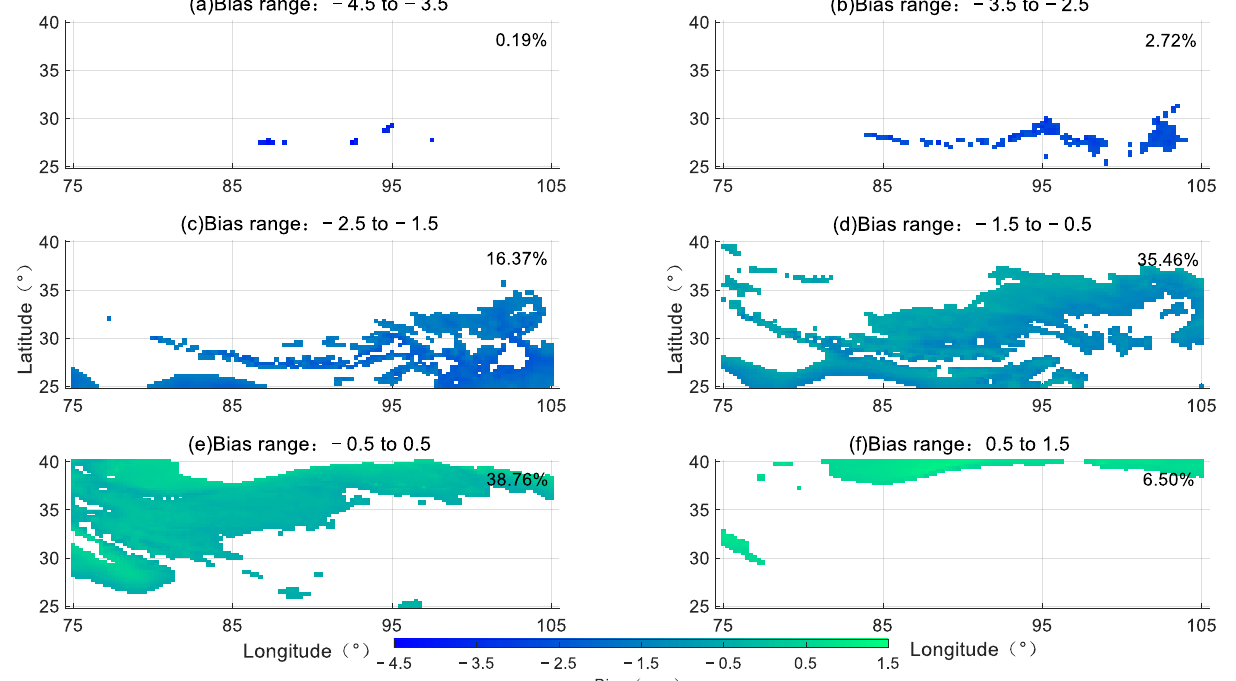
Figure 10. The bias distribution of ASV-PWV.